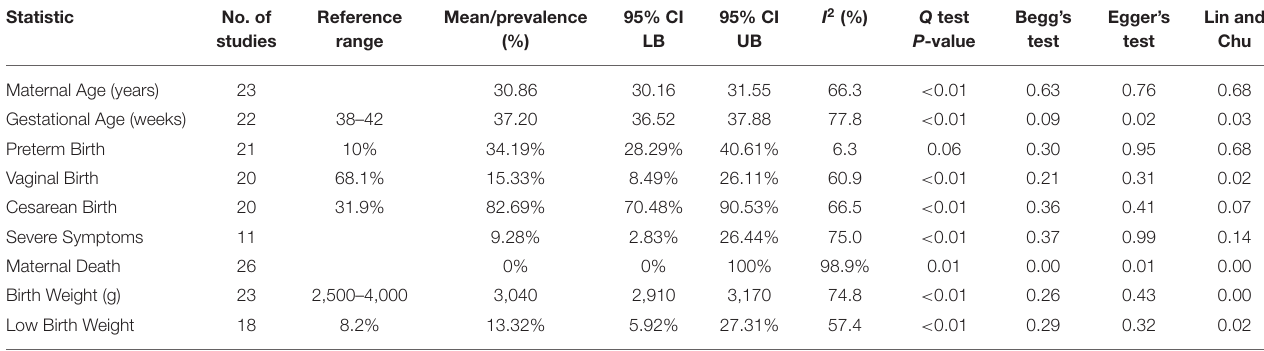
TABLE 2 | Meta-analysis of general maternal and neonatal